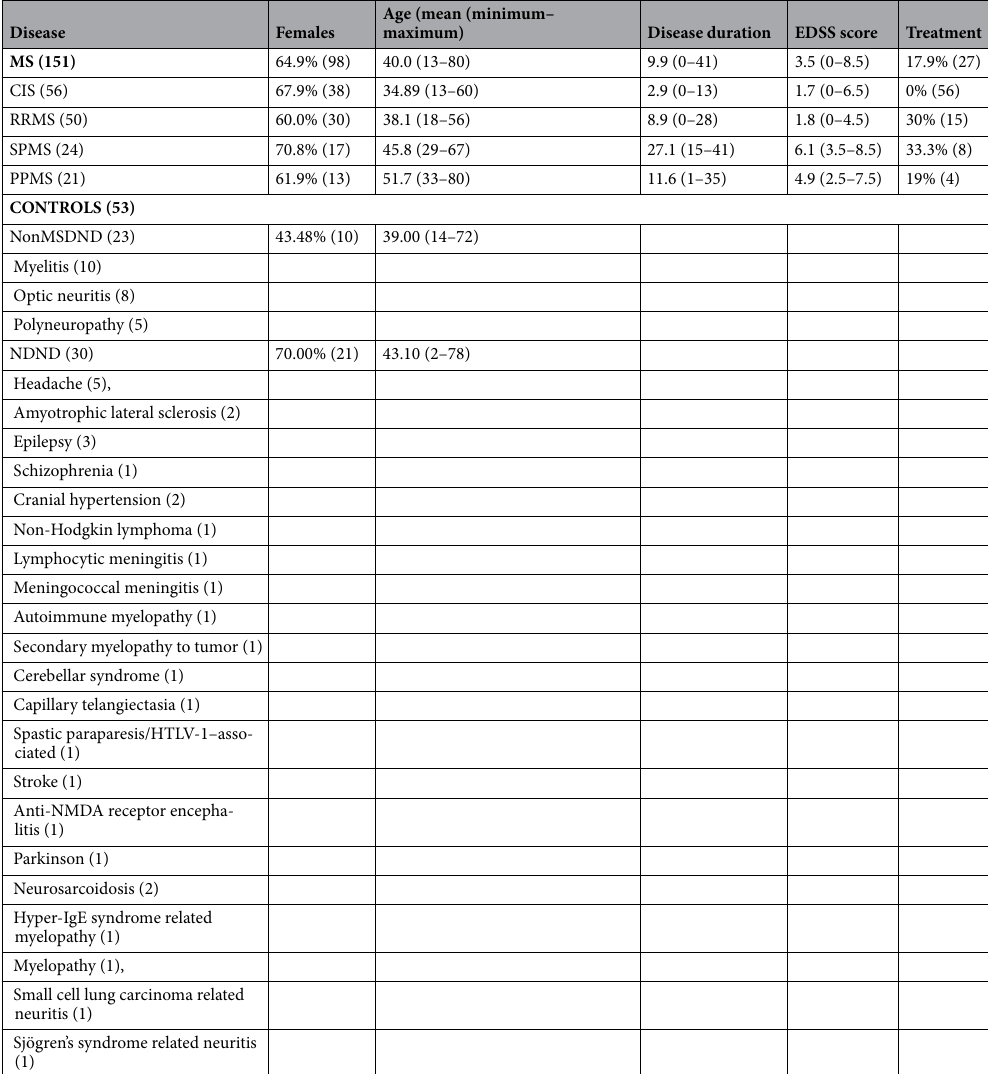
Table 1. Demographic and clinical data from patients with MS, NonMSDND and NDND. MS multiple sclerosis, CIS clinically isolated syndrome, RRMS relapsing–remitting multiple sclerosis, SPMS